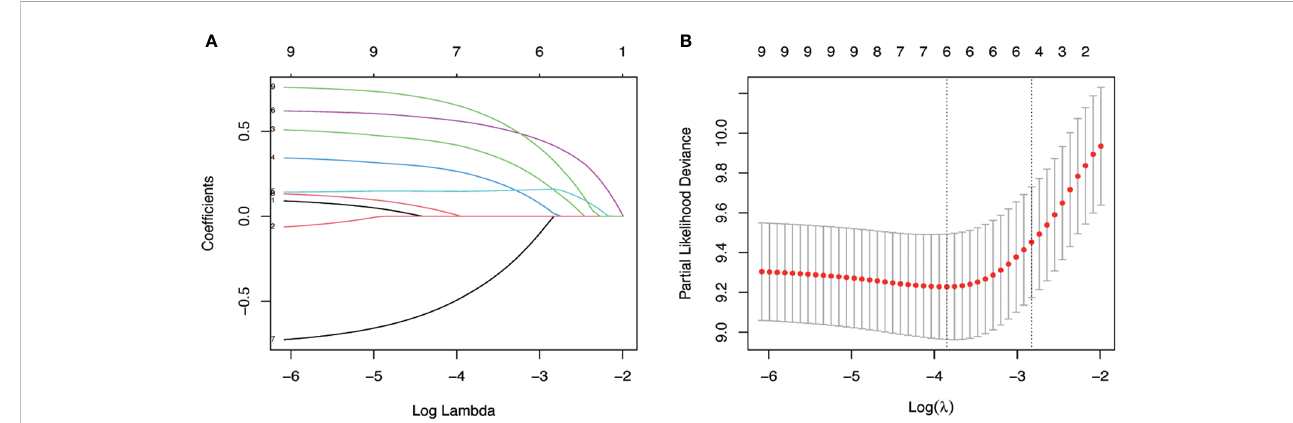
FIGURE 2 Identi fi cation of key variables via LASSO cox regression analysis. (A) LASSO coef fi cient pro fi les of the nine variables for OS. (B) Identi fi cation of the optimal penalization coef fi cient lambda ( l =0.078) in the LASSO model with 10-fold cross-validation for